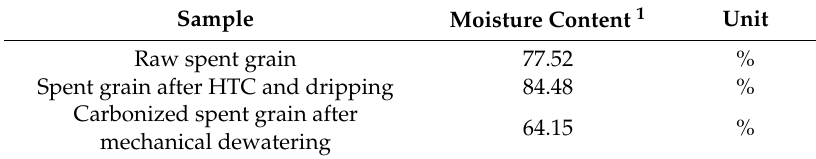
Table 3. Mechanical de-watering of the spent grain after HTC results.